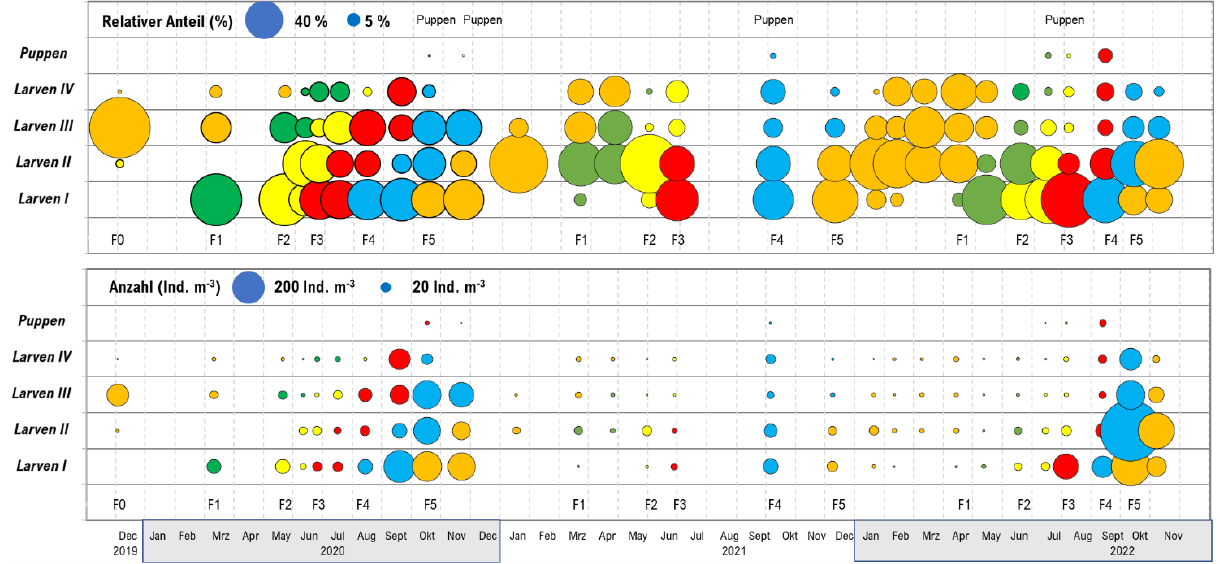
Figure 8. The population dynamics of Paratanytarsus grimmii in a drinking water distribution system in Northern Germany, showing the relative proportions of the population in larval stages L1 to L4 (top panel) and the total number of larvae in all stages (bottom panel) (in ind. m −3 ). The areas of the dots correspond to the relative proportions of the total number of larvae. The colors represent the different generations.